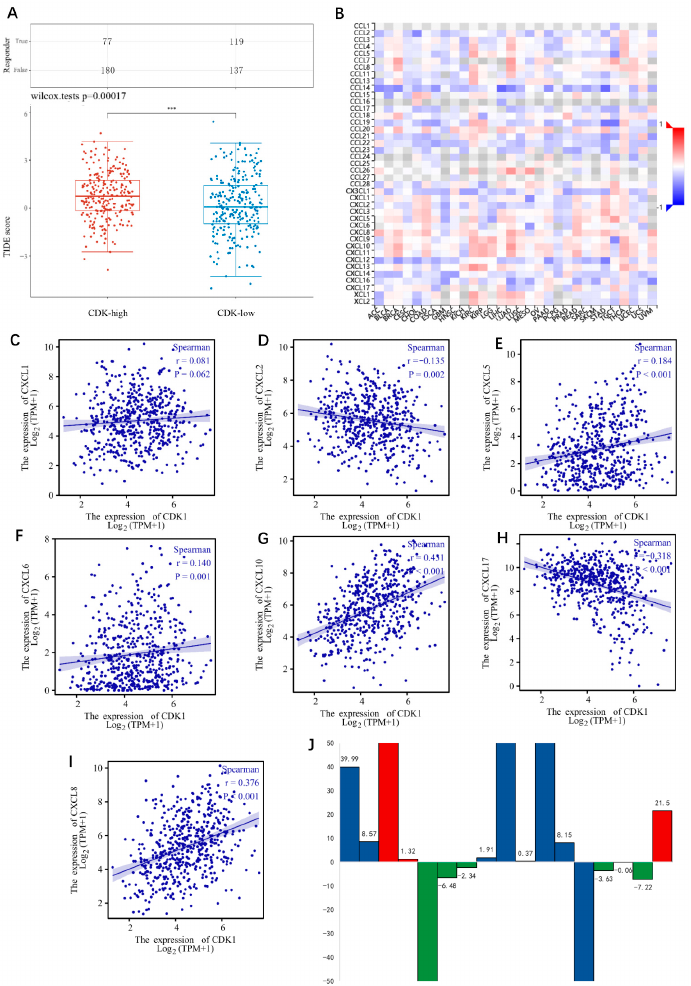
Figure 4. ( A ) The correlation between the expression of CDK1 and the response of immune checkpoint inhibitors. *** p < 0.001. ( B ) The correlation heatmap between CDK1 and immune regulatory factors drew by TISIDB. ( C – I ) Correlation analysis of CDKs and CXCLs; ( C ) CDK1 and CXCL1; ( D ) CDK1 and CXCL2; ( E ) CDK1 and CXCL5; ( F ) CDK1 and CXCL6; ( G ) CDK1 and CXCL10; ( H ) CDK1 and CXCL17; ( I ) CDK1 and CXCL8. The data for analysis were from the LUAD project in TCGA database. ( J ) Fluctuation of IL8 in peripheral blood during immunotherapy in 17 lung adenocarcinoma patients. Red represents immunotherapy resistant population; green represents the immunotherapy effective population; blue represents the population in which immunotherapy efficacy could not be